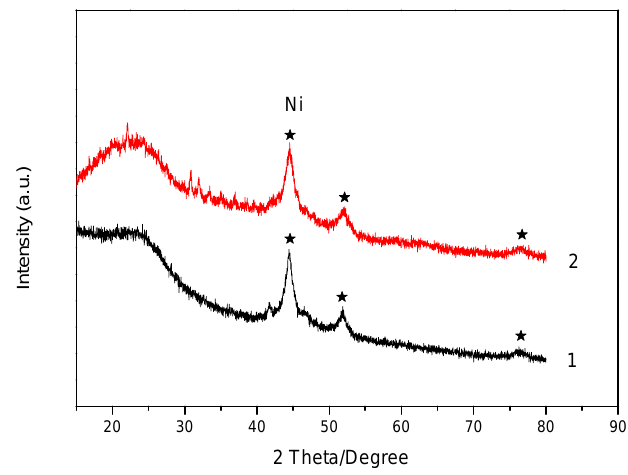
Figure 5. XRD patterns of ( 1 ) fresh Ni/C; ( 2 ) Ni/C after six times reaction.